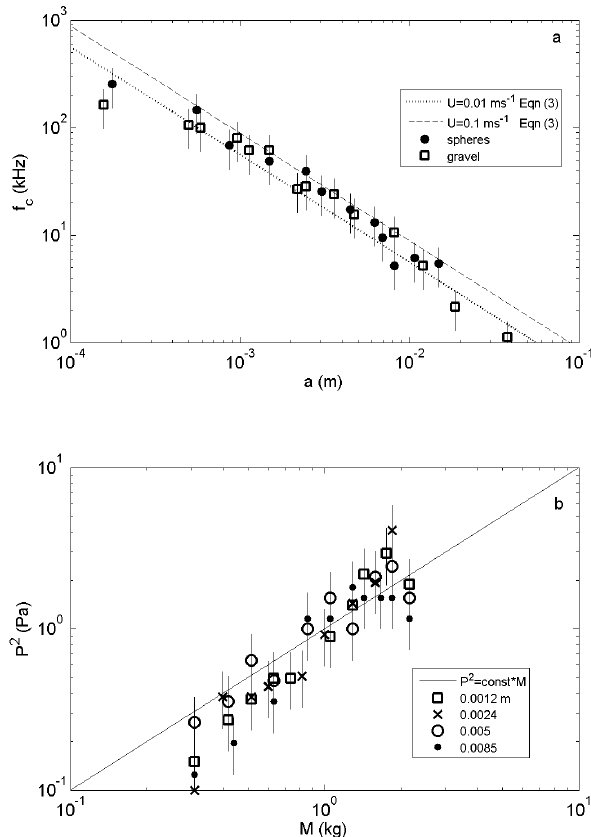
Figure 7. (a) Calculated characteristic central frequency, f c , ob- tained using Eq. (3) and measurements with particle radius, a . (b) The mean square pressure, P 2 , with mass, M , compared with Eq. (4). Measurements were collected under quasi-bedload con- ditions. Measurements are from Jonys (1976), Millard (1976), Thorne (1985) and Thorne